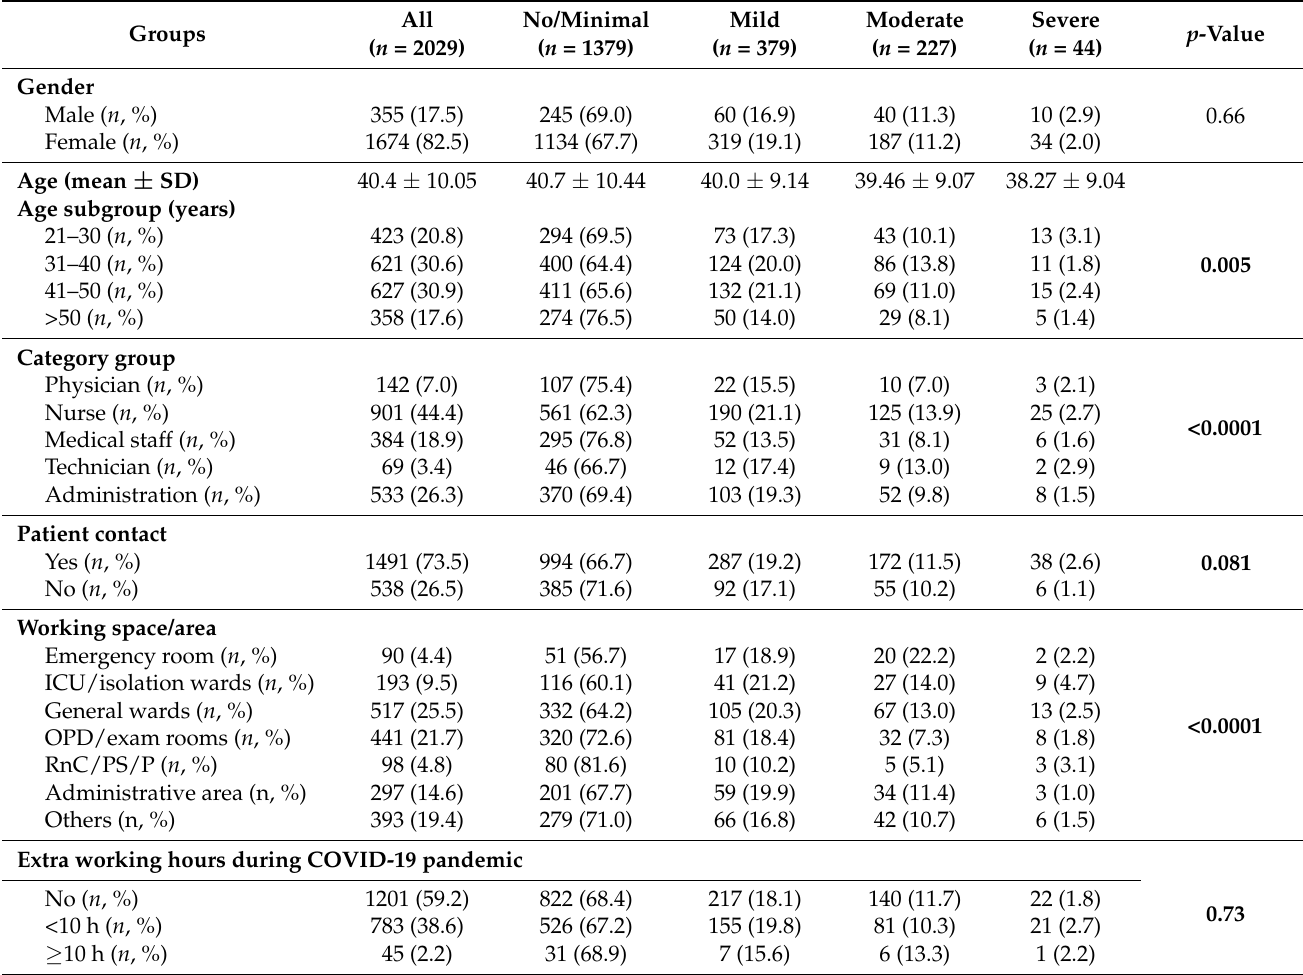
Table 1. Characteristics of the study population.